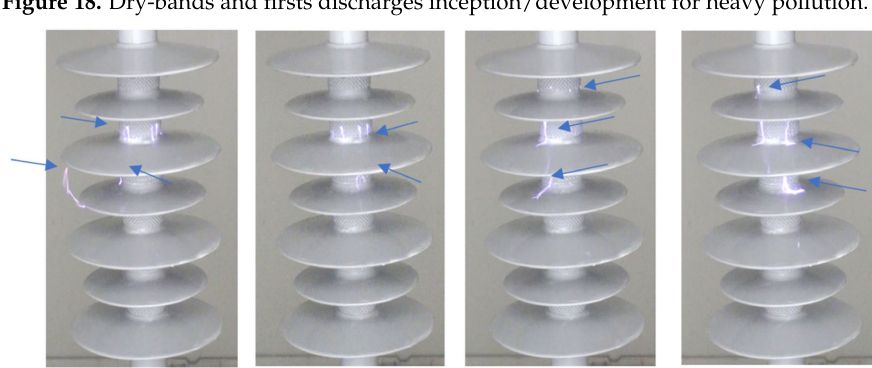
Figure 19. Discharges development with the voltage step increase for heavy